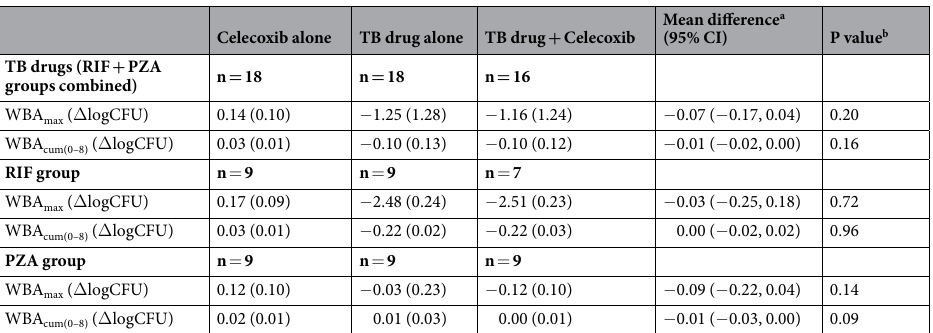
Mean difference a (95% CI) P value b